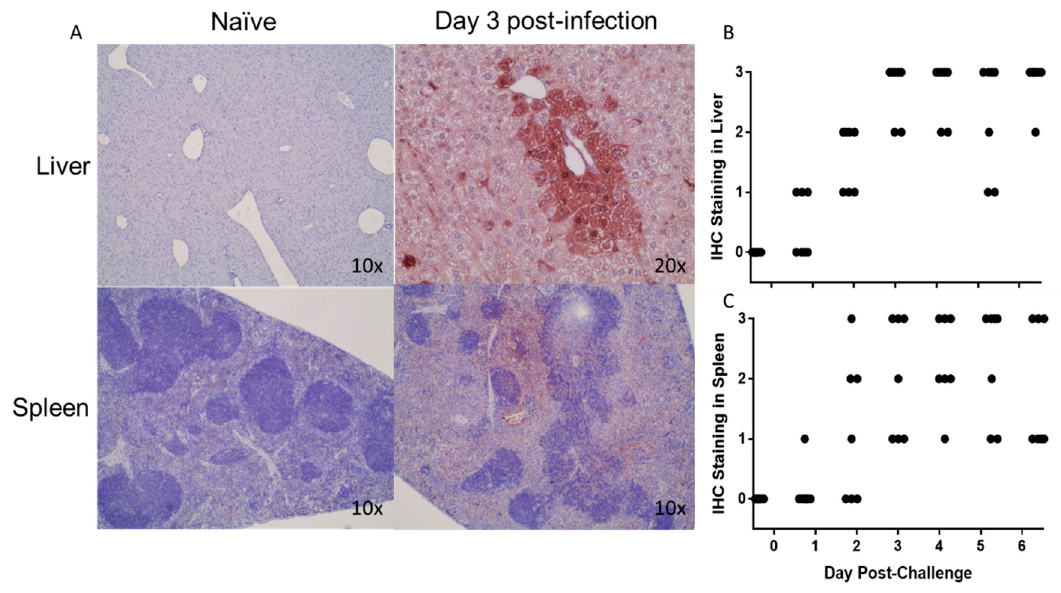
Figure 7. IHC Staining of Liver and Spleen. Virus antigen in liver and spleen samples were labeled with a rabbit anti-Zaire Ebola VLP polyclonal antibody. Virus antigen specific staining is was compared at different time points ( A ). The incidence of viral straining over time was measured in the liver ( B ) and spleen ( C ) using the following scale: 0 = no staining, 1 = rare, 2 = frequent, 3 = diffuse.